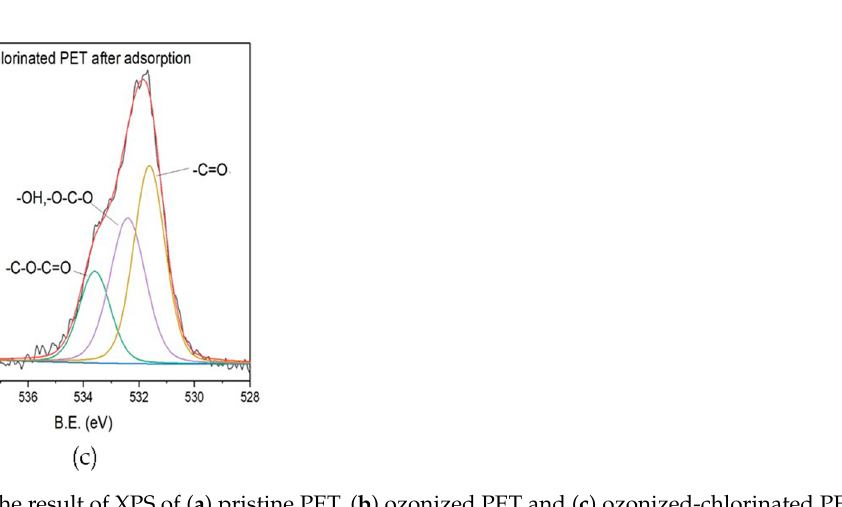
after after adsorption.